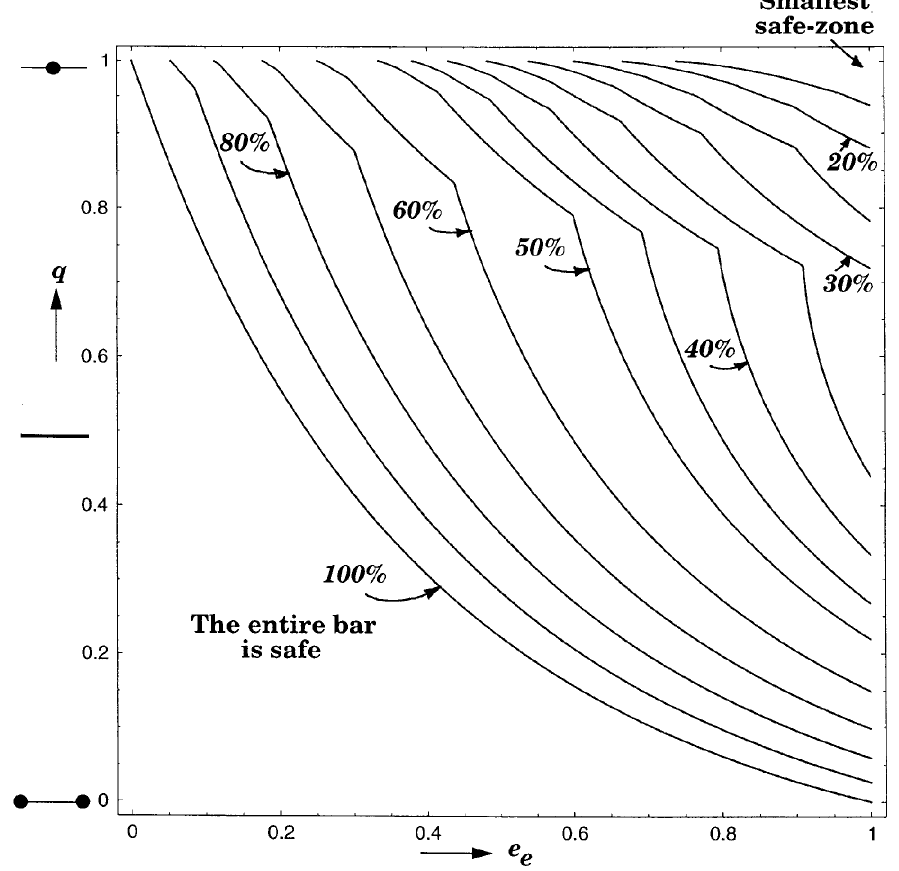
Fig. 7. Contour-plots of constant values of s for maximal velocity shock thresholds, ∆ v max s = 2 v 0 during clattering. The plot shows that the entire design provides bar configurations to meet the above threshold. For a given e e , the extent of the safe-zone can be increased by decreasing q